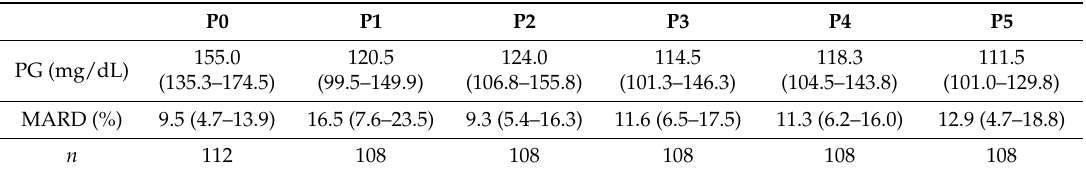
Figure 1. Plasma glucose (PG) and continuous glucose monitoring (CGM) measurements from P0 to P5 for aerobic sessions. Data shown are mean ± standard deviation (SD). PG is denoted by the black solid line and black-shaded area. CGM is denoted by the blue solid line and blue-shaded area. The vertical dashed line indicates the start of aerobic exercise sessions.